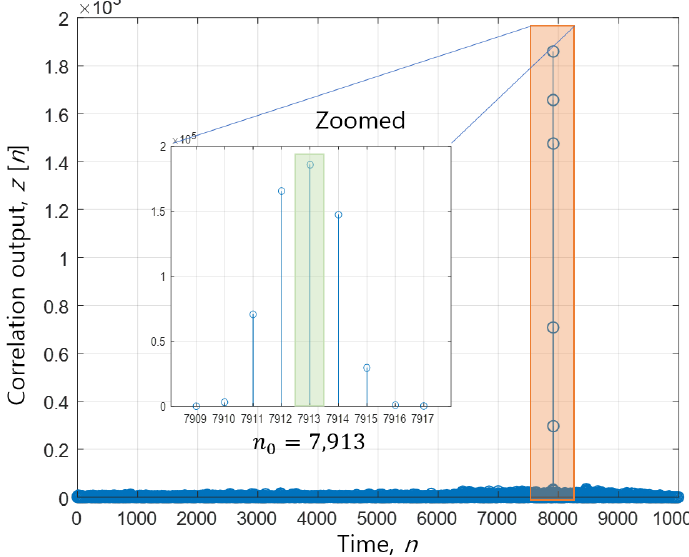
Figure 3. Example of the correlator output, z [ n ] , when W = 10,000 and SNR = 0.9 dB.